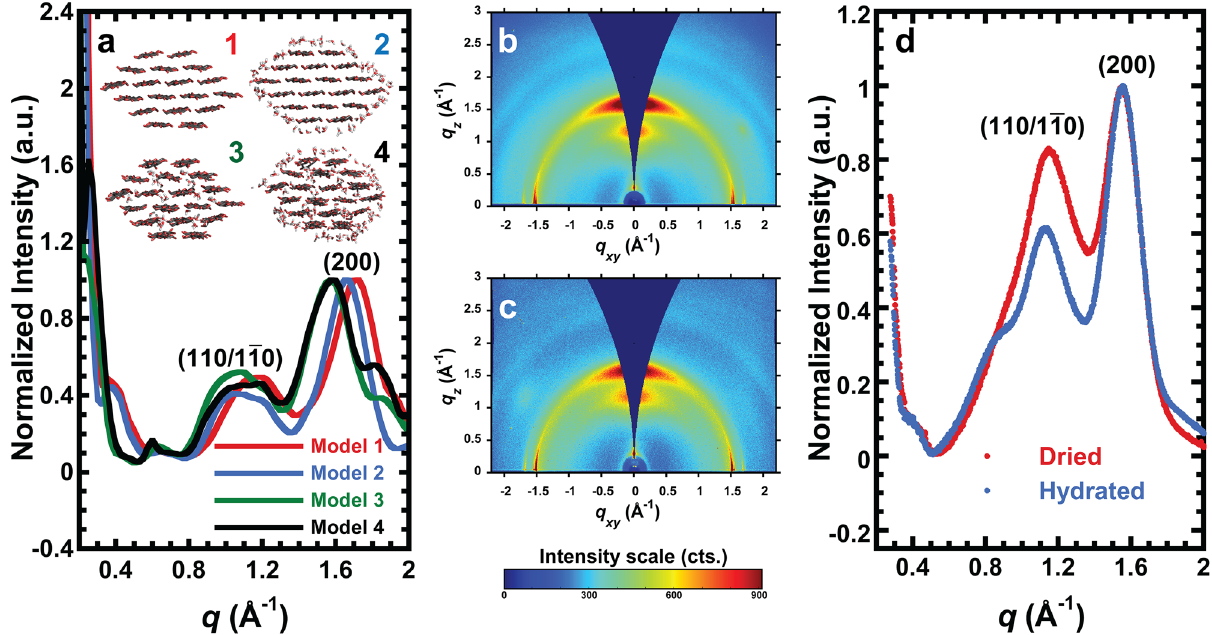
Figure 1. Theoretical and experimental X-ray scattering data. ( a ) Predicted scattering curves of CMF models normalized to the (200) maximum peak intensity. Inset: Potential crystal habits of cellulose microfibrils with (1) no H 2 O molecules, (2) monolayer of H 2 O molecules on the outside of the cellulose crystal, (3) H 2 O molecules inside the cellulose microfibril, and (4) H 2 O molecules inside the cellulose microfibril and a monolayer of H 2 O molecules on the outside surface. ( b , c ) GIWAXS data for onion epidermal wall in ( b ) hydrated and ( c ) dried states. q z and q xy denote out-of-plane and in-plane scattering vectors, respectively. ( d ) GIWAXS out-of-plane profiles of hydrated (blue) and dried (red) onion epidermal wall. A linear background was subtracted and data are normalized to the (200) peak intensity for comparison to ( a ). Profiles are averaged over three